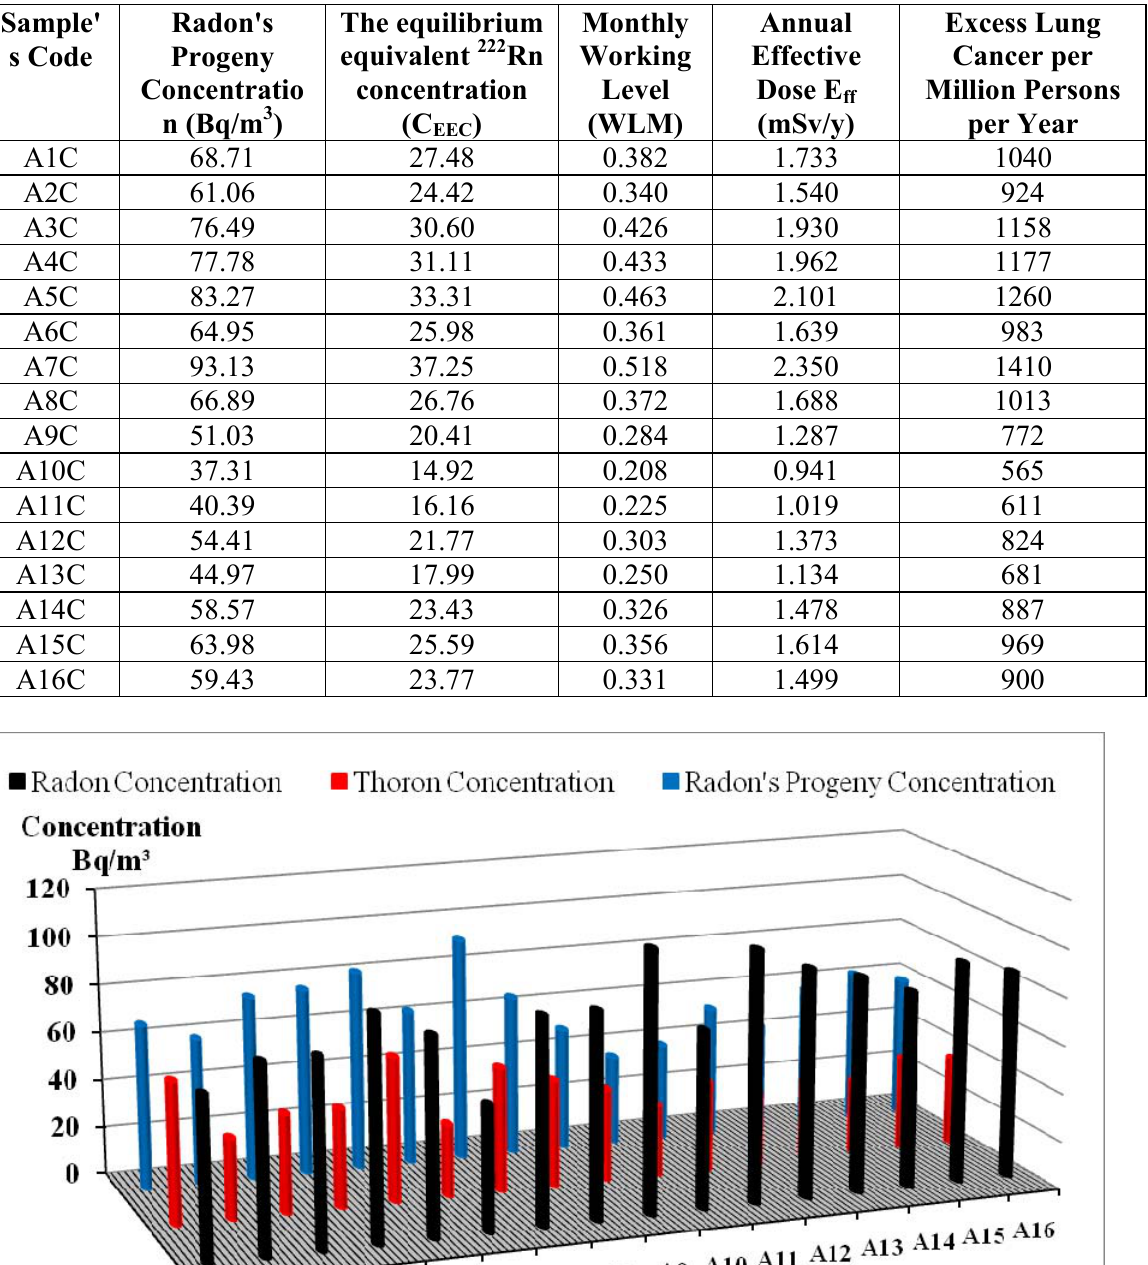
Table 5: The overall results of radon's progeny only.